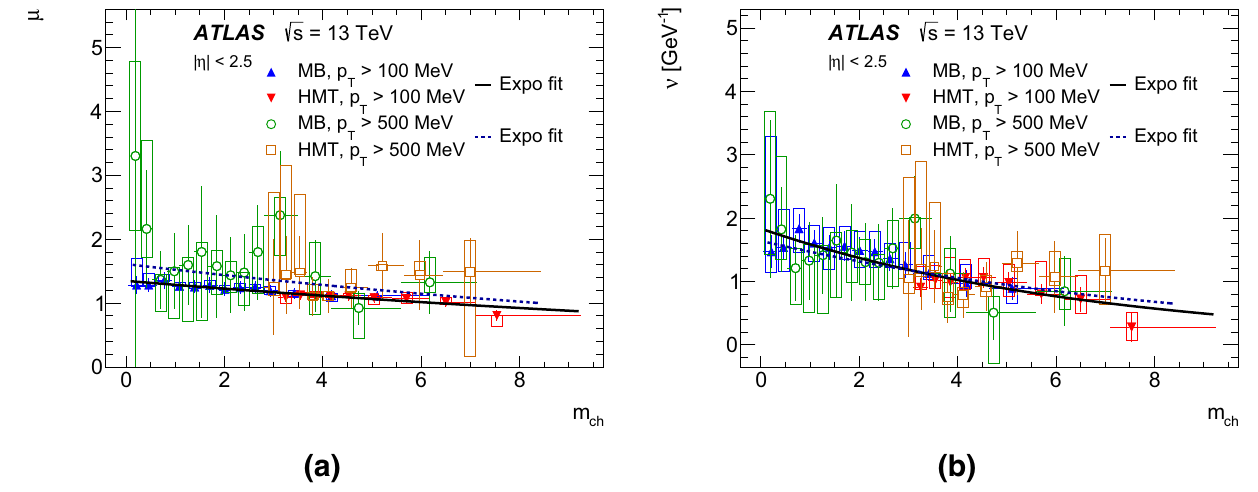
Fig. 10 The fit parameters a μ and b ν (Eq. (8)), describing the depen- dence of the correlation strength, λ , on charged-particle scaled multi- plicity (Eq. (5)), for track p T > 100 MeV and track p T > 500 MeV in the minimum-bias (MB) and high-multiplicity track (HMT) samples